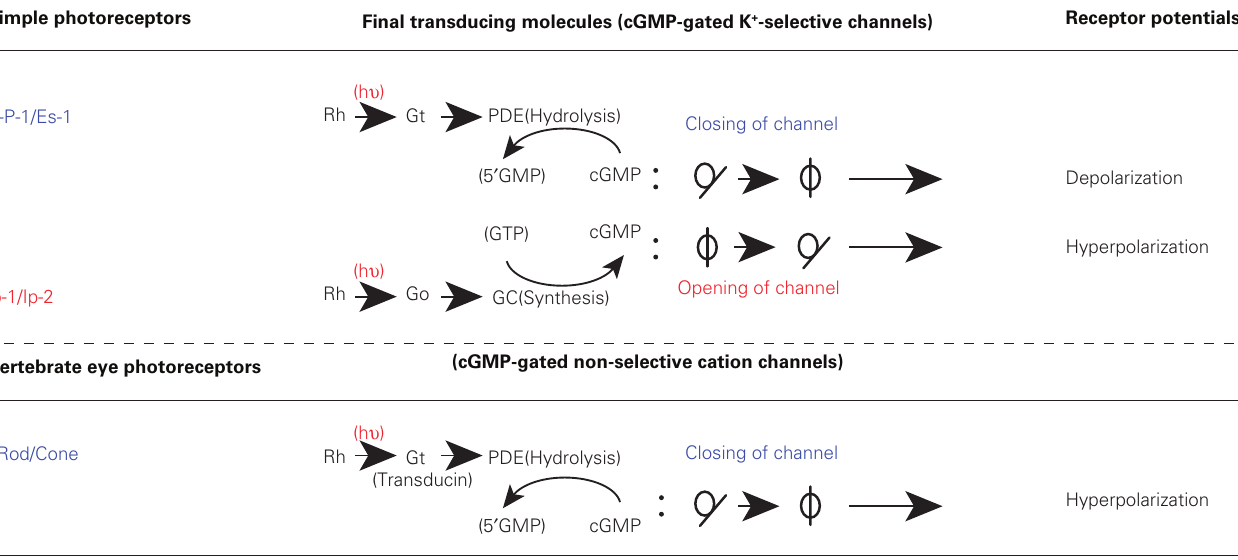
Table 1 | Phototransduction cGMP cascade models of simple photoreceptors. Simple